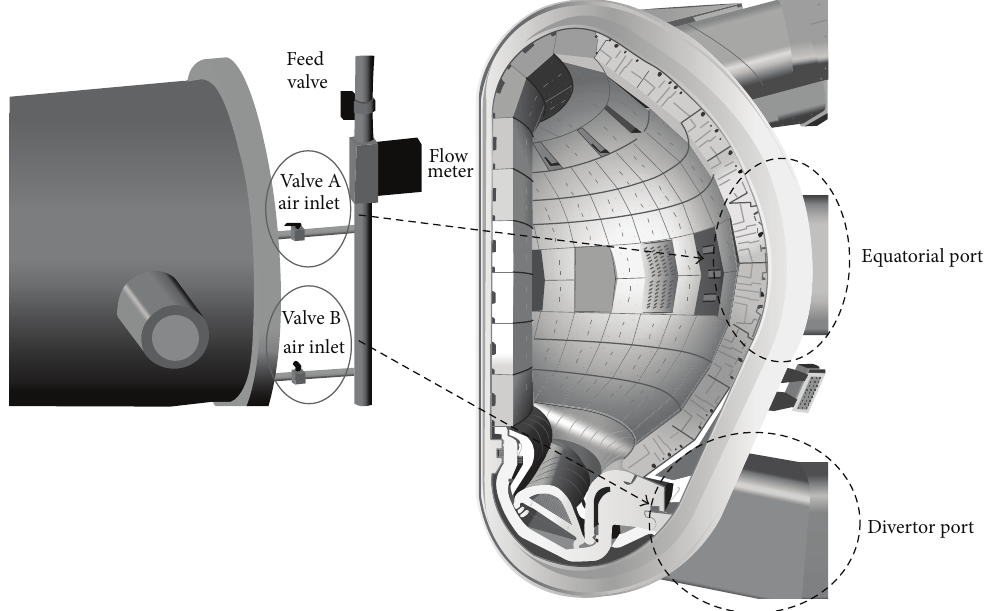
Figure 10: Valve A and Valve B on STARDUST